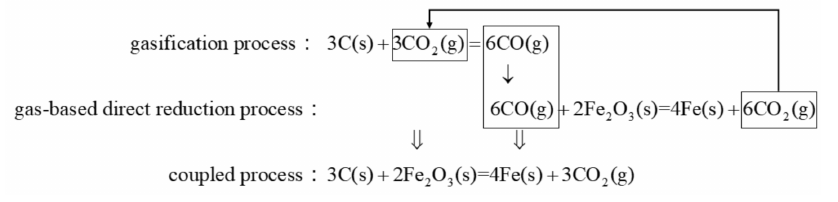
Figure 21. The coupled process and separated